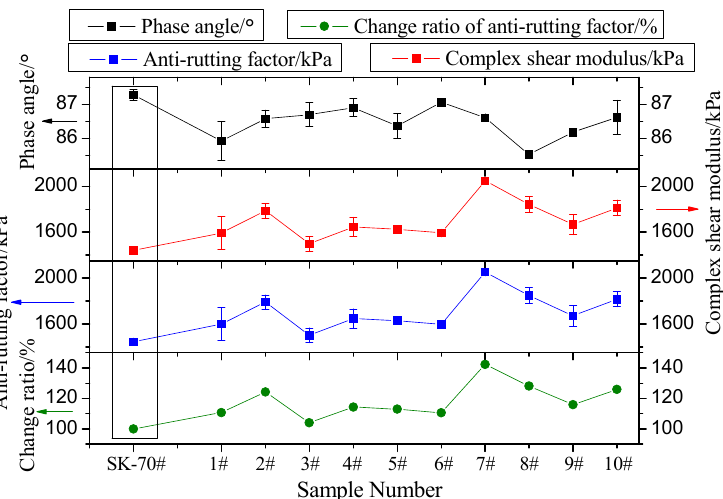
Figure 3. SHRP-PG test results (64 °C): The changing trends of phase angle, complex shear modulus, antirutting factor, and change ratio of antirutting factor are shown separately. The change ratio of antirutting factor is that the antirutting factor of each test group is divided by the antirutting factor of SK-70# base asphalt.